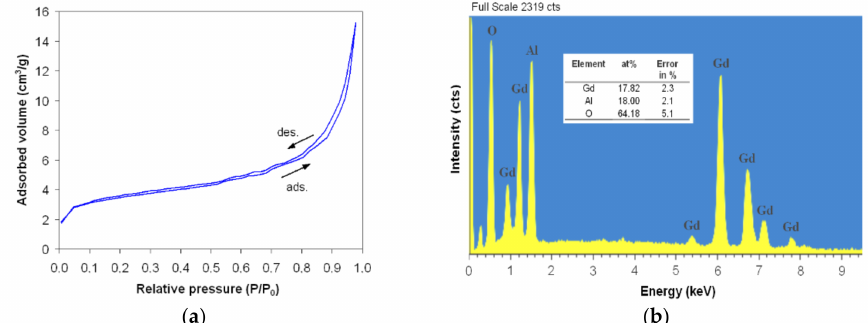
Figure 5. N 2 adsorption/desorption isotherms ( a ) and EDX spectrum with the analyzed elements ( b ) for gadolinium aluminate powder, heat treated at 1000 ◦ C for 7